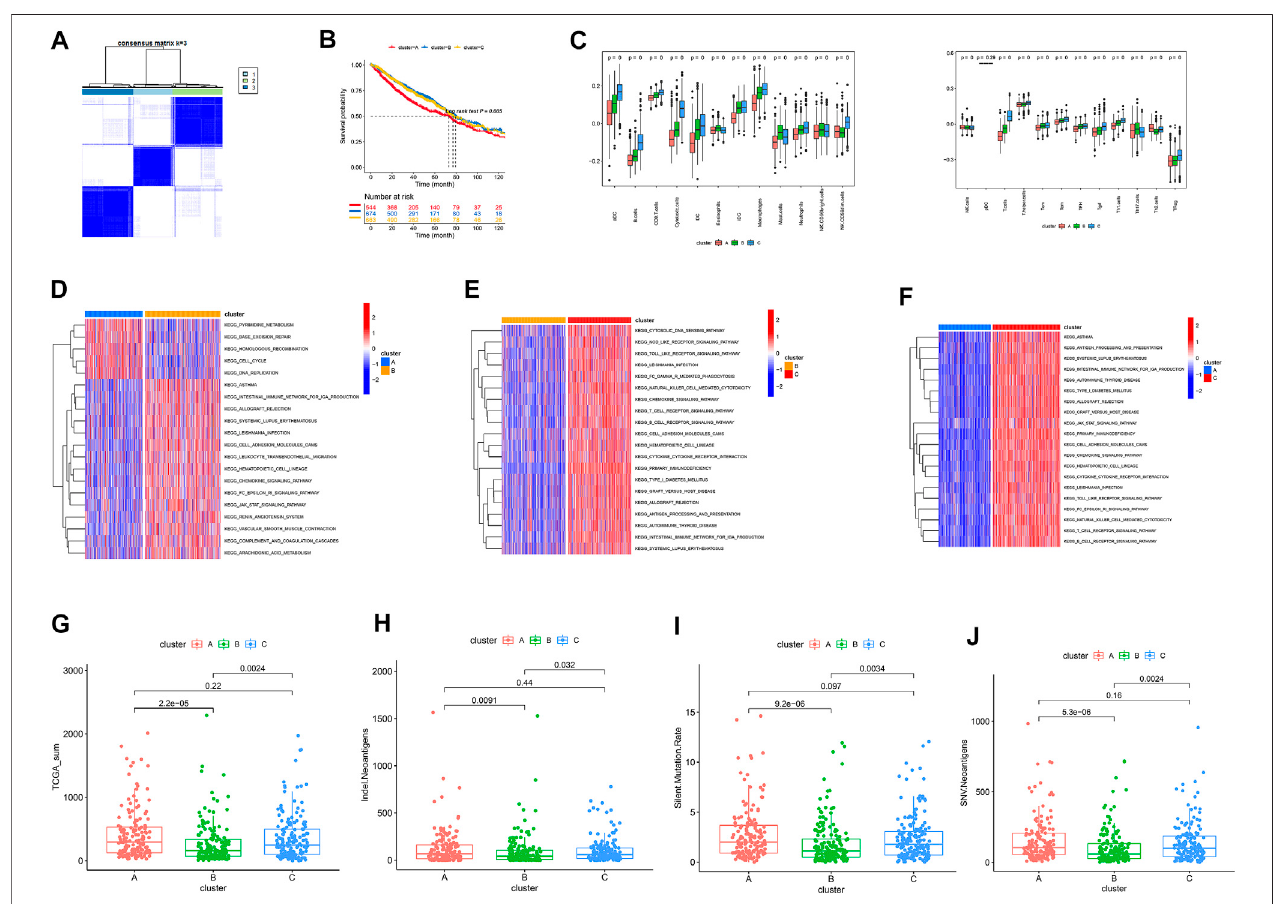
FIGURE 2 | (A) Identi fi cation of three clusters by consensus clustering. (B) Patient survival analysis. (C) Landscapes of immune cell in fi ltration. (D – F) KEGG analysis. (G – J) Distribution of TMB, neo-antigens (Indel, SNV), and silent mutation rate in the three